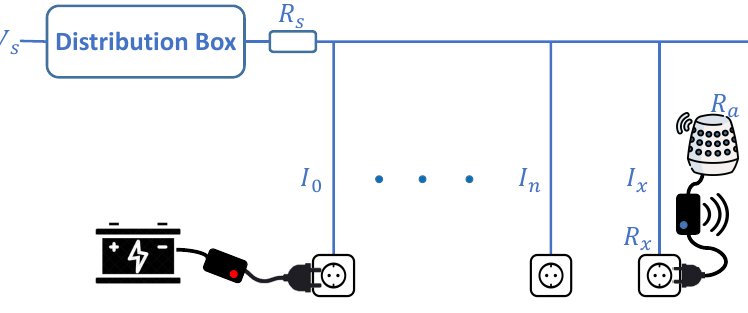
Figure 5. Illustration of the household